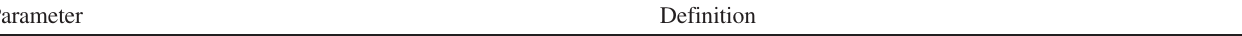
TABLE IV. Definitions for Q-factor calculations. Parameter